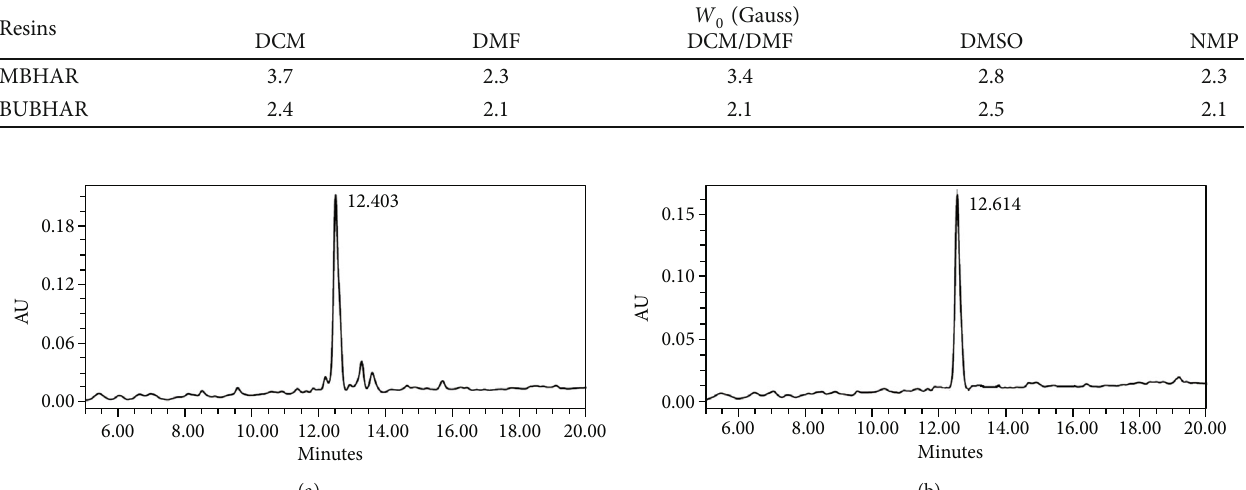
Figure 2: Electron paramagnetic resonance ( EPR) spectra of Toac-labeled Asn-Cys-Pro-(D-Arg)-Gly segment bound to MBHAR (a) and to BUBHAR (b) in 50% DCM/DMF. ff erent organic solvents for Asn-Cys-Pro-(D-Arg)-Gly peptide segment coupled to MBHAR and to Table 2: EPR W 0 values determined in di BUBHAR and labeled with Toac spin label.